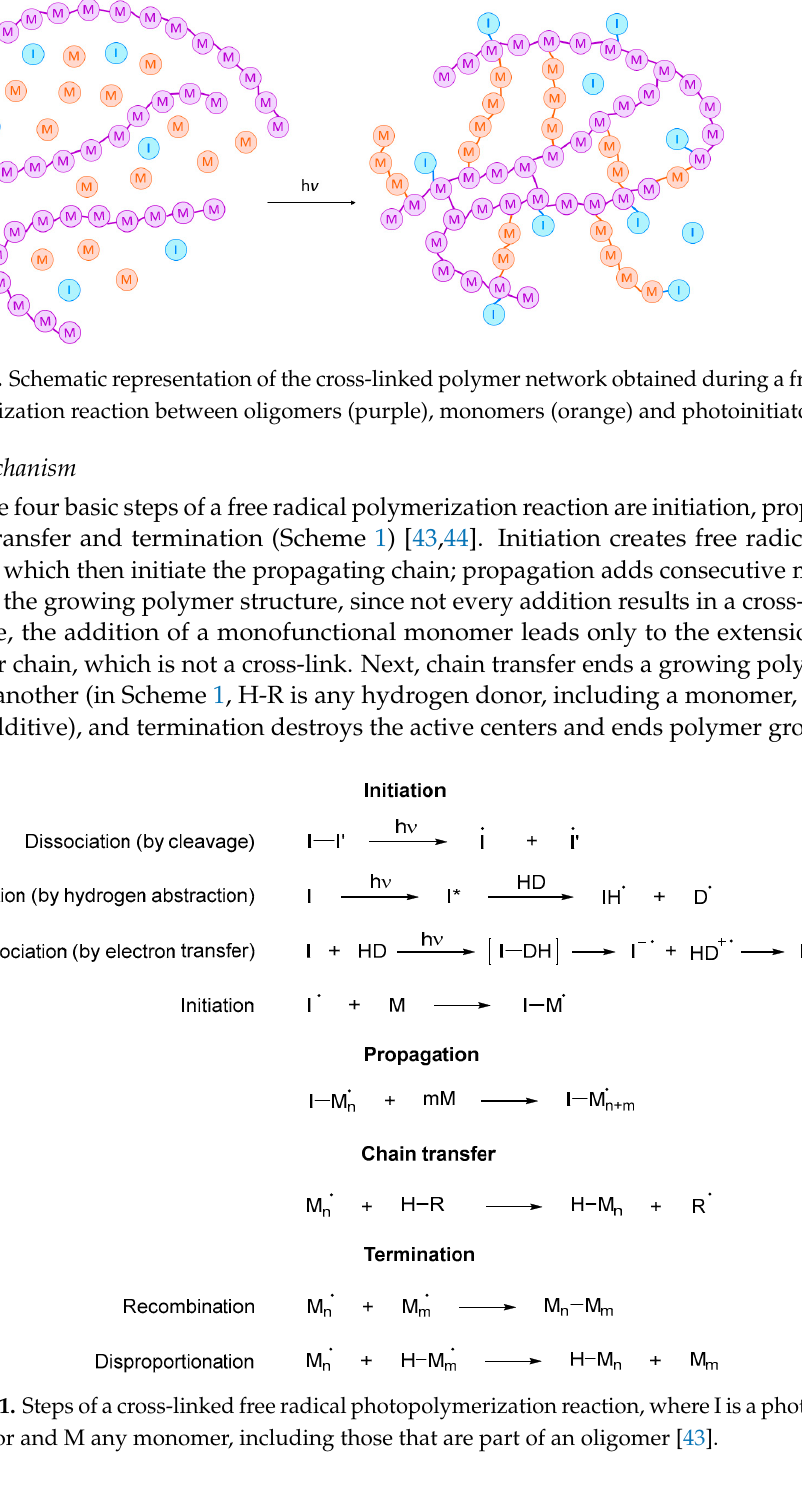
Chart 1. Schematic outline of the review on free radical photopolymerization for curing products.